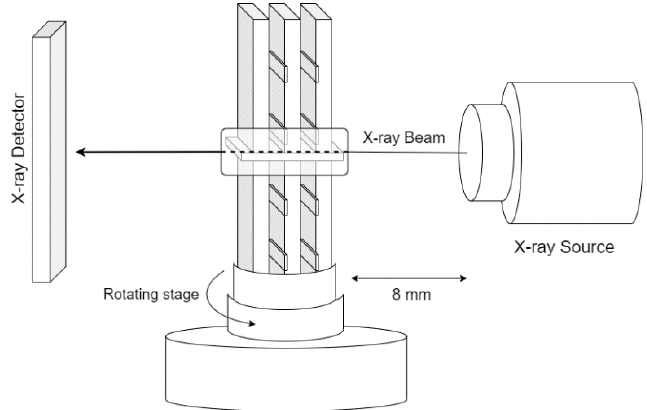
Figure 4. Scheme X-ray scanning.